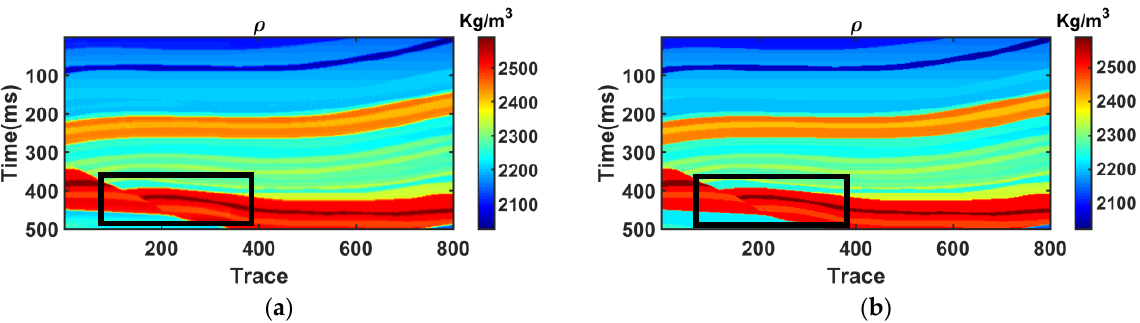
Figure 6. Density inversion results based on (a) traditional method and (b) reweighted Lp method.